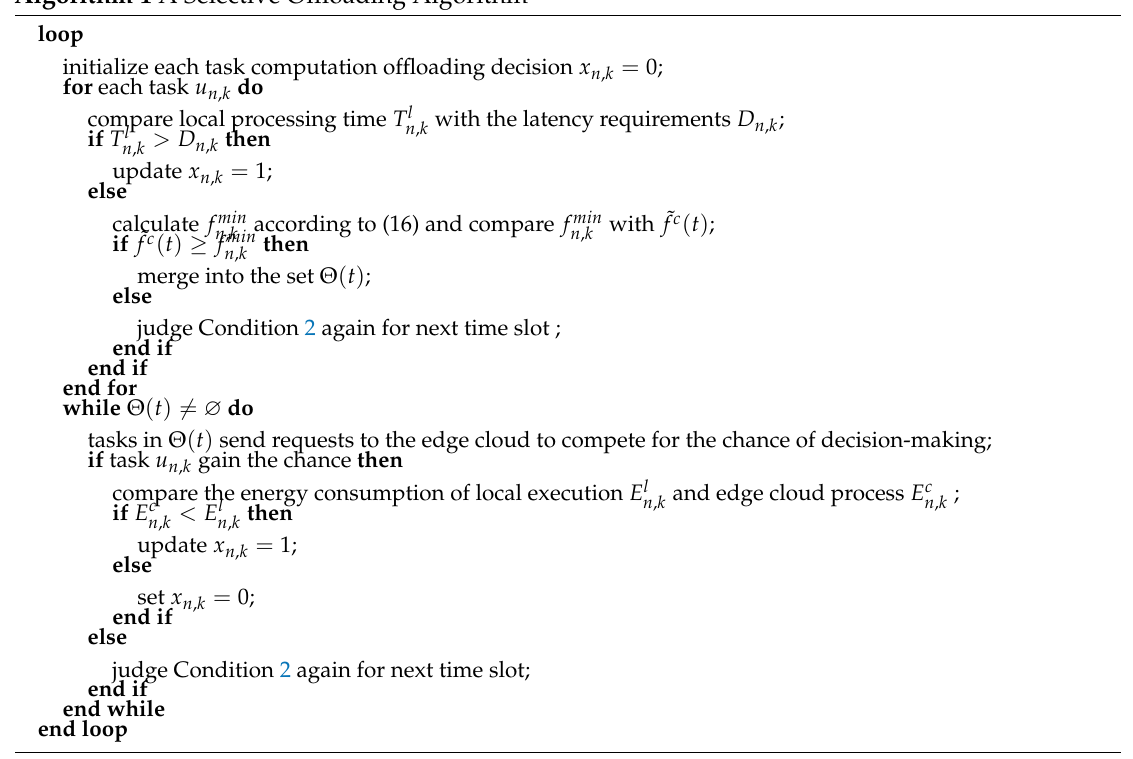
Algorithm 1 A Selective Offloading